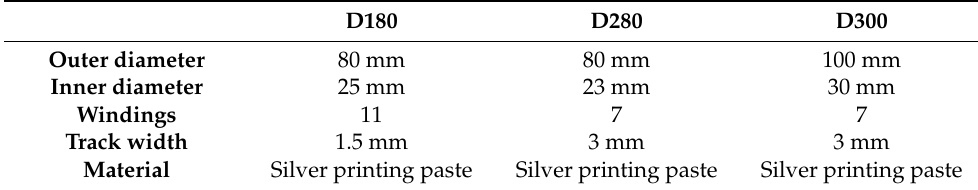
Figure 6. Printed coils according to the Qi standard: Primer ( left ), printing stencil ( middle ) and printed coils ( right ). Table 5. Structure of the wound coils according to Qi standard